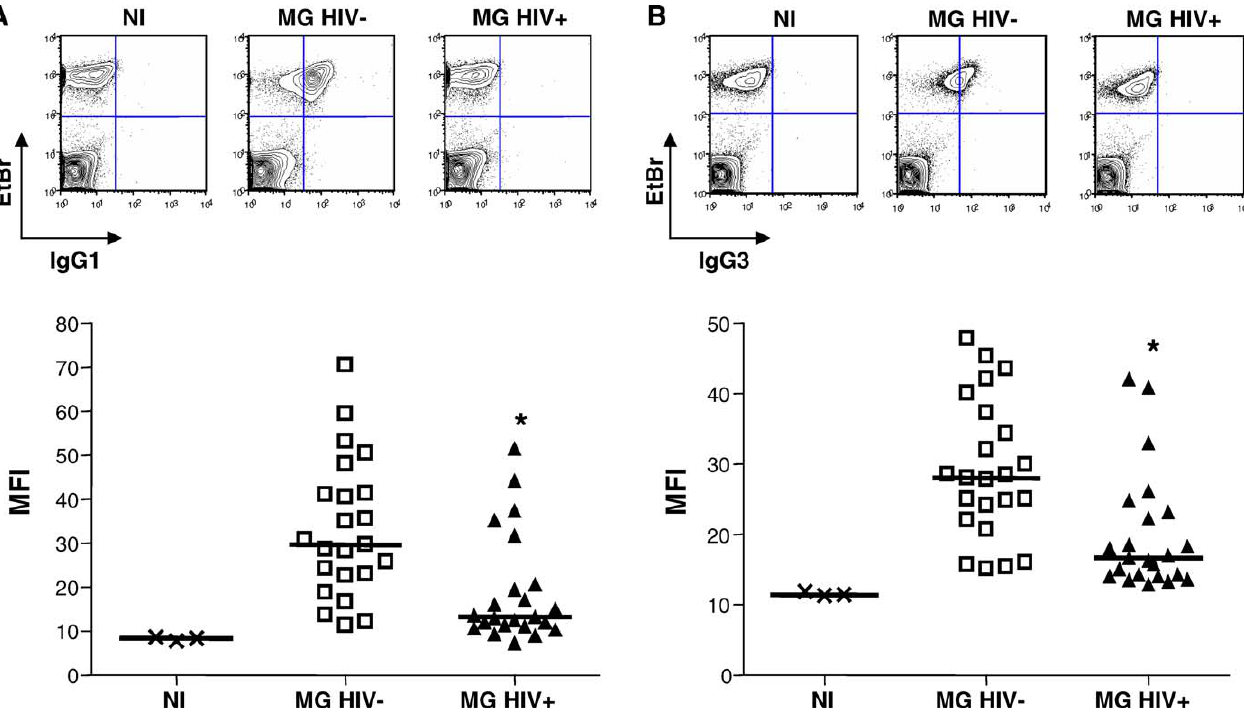
Figure 5. HIV-Infected Multigravid Women Have Lower Levels of VSA-PAM-Specific IgG1 and IgG3 Flow cytometry was used to measure levels of IgG1 (A) and IgG3 (B) with specificity for VSA expressed by CS2 PEs in plasma from NI ( n ¼ 3), MG HIV (cid:2) ( n ¼ 23), and MG HIV þ donors ( n ¼ 23). Data shown are MFIs for IgG1 and IgG3 from individual donors gated on EtBr positive cells (PEs). Horizontal bars indicate the median. Inserts show contour plots of a NI, MG HIV (cid:2) , and MG HIV þ donor, respectively. Statistical significance was assessed by Mann- Whitney rank sum test. *MG HIV (cid:2) versus MG HIV þ p , 0.001. MG HIV (cid:2) , HIV-negative MG; MG HIV þ , HIV-infected MG; NI, nonimmune. doi:10.1371/journal.pmed.0040181.g005 PLoS Medicine |